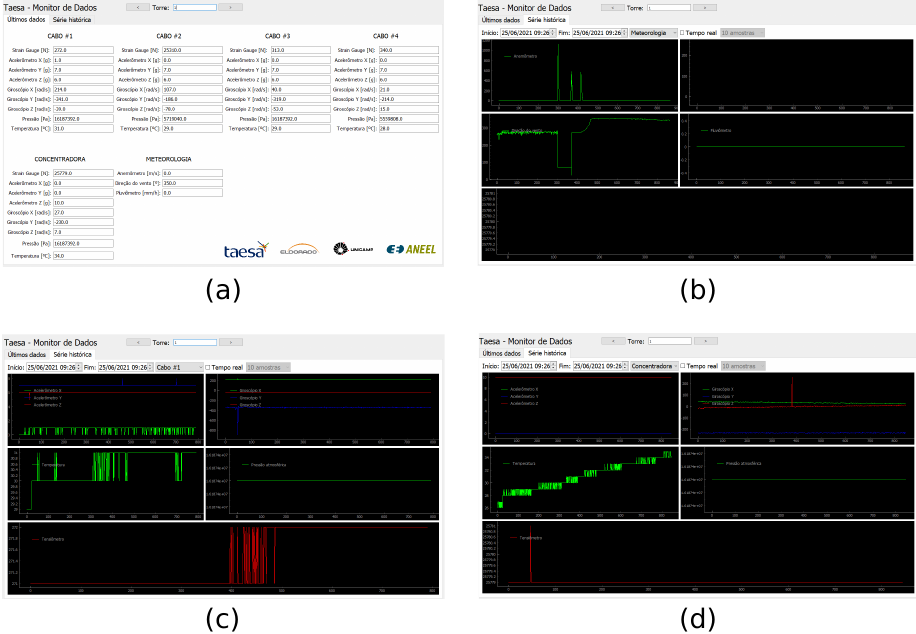
Figure 13. User interface samples from the central server: ( a ) View of leaf nodes data from sensor cables, accelerometers, and weather stations, ( b ) View of history data plot of the weather station, ( c ) View of history data plot of cable 1, and ( d ) View of history data plot of the central